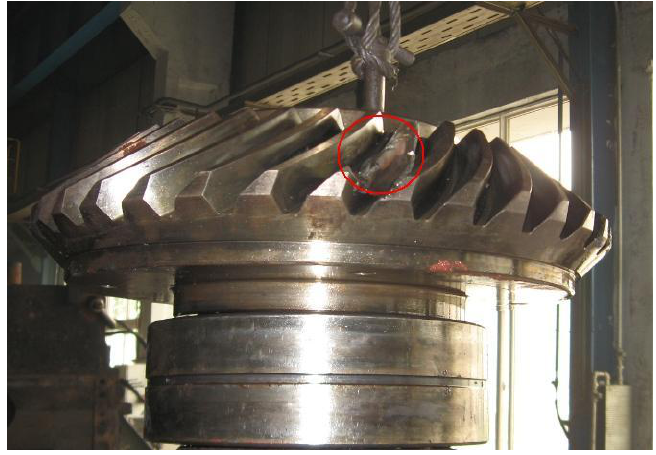
Figure 14. The real case of a broken cog fault of bevel gear Z2 (tooth 35).